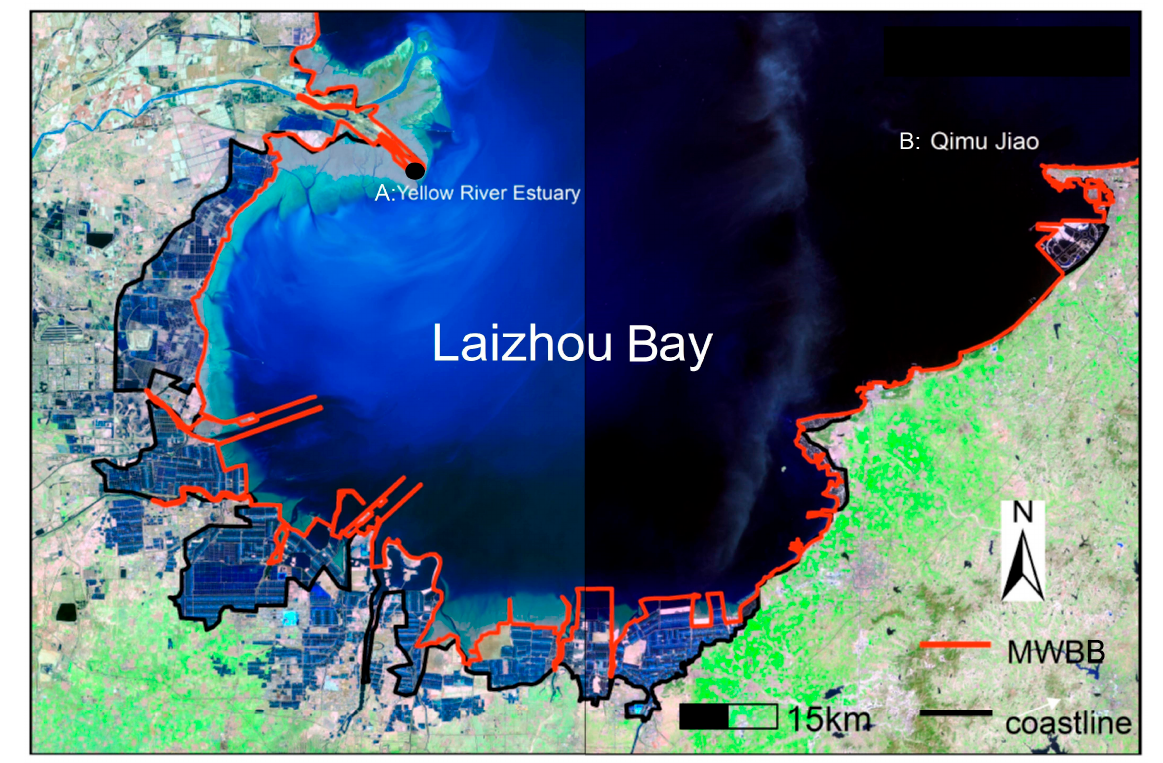
Figure 3. Comparison of positions of the MWBB and coastline in Laizhou Bay (from the Yellow River Mouth to Qimujiao). Table 2. Boundary defining methods of MWBB with different utilization